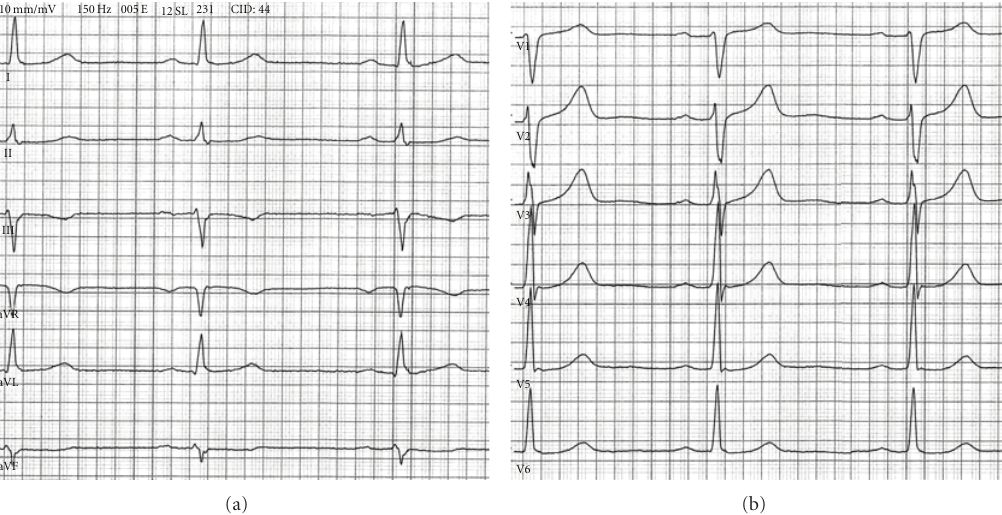
Figure 2: Electrocardiogram from the patient of Figure 1 with electrodes in the right positions. Note that lead II is not modified, given that there was no interchange between electrodes of the right arm and the left leg. The R wave becomes incrementally larger from leads V1 to